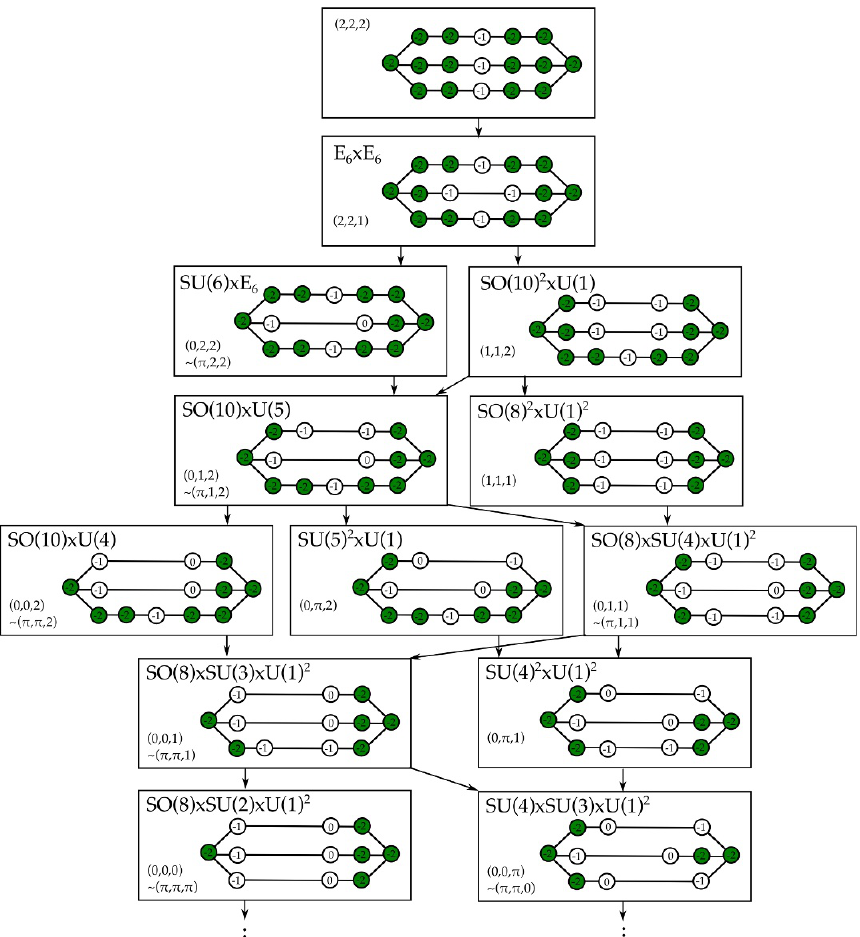
Figure 16 . Subtree of the (E 6 ; E 6 ) CFD-tree. The full CFD-tree can be seen in [89] and has 93 descendants. The theories that have a known quiver description, and comprise a small subset, are shown